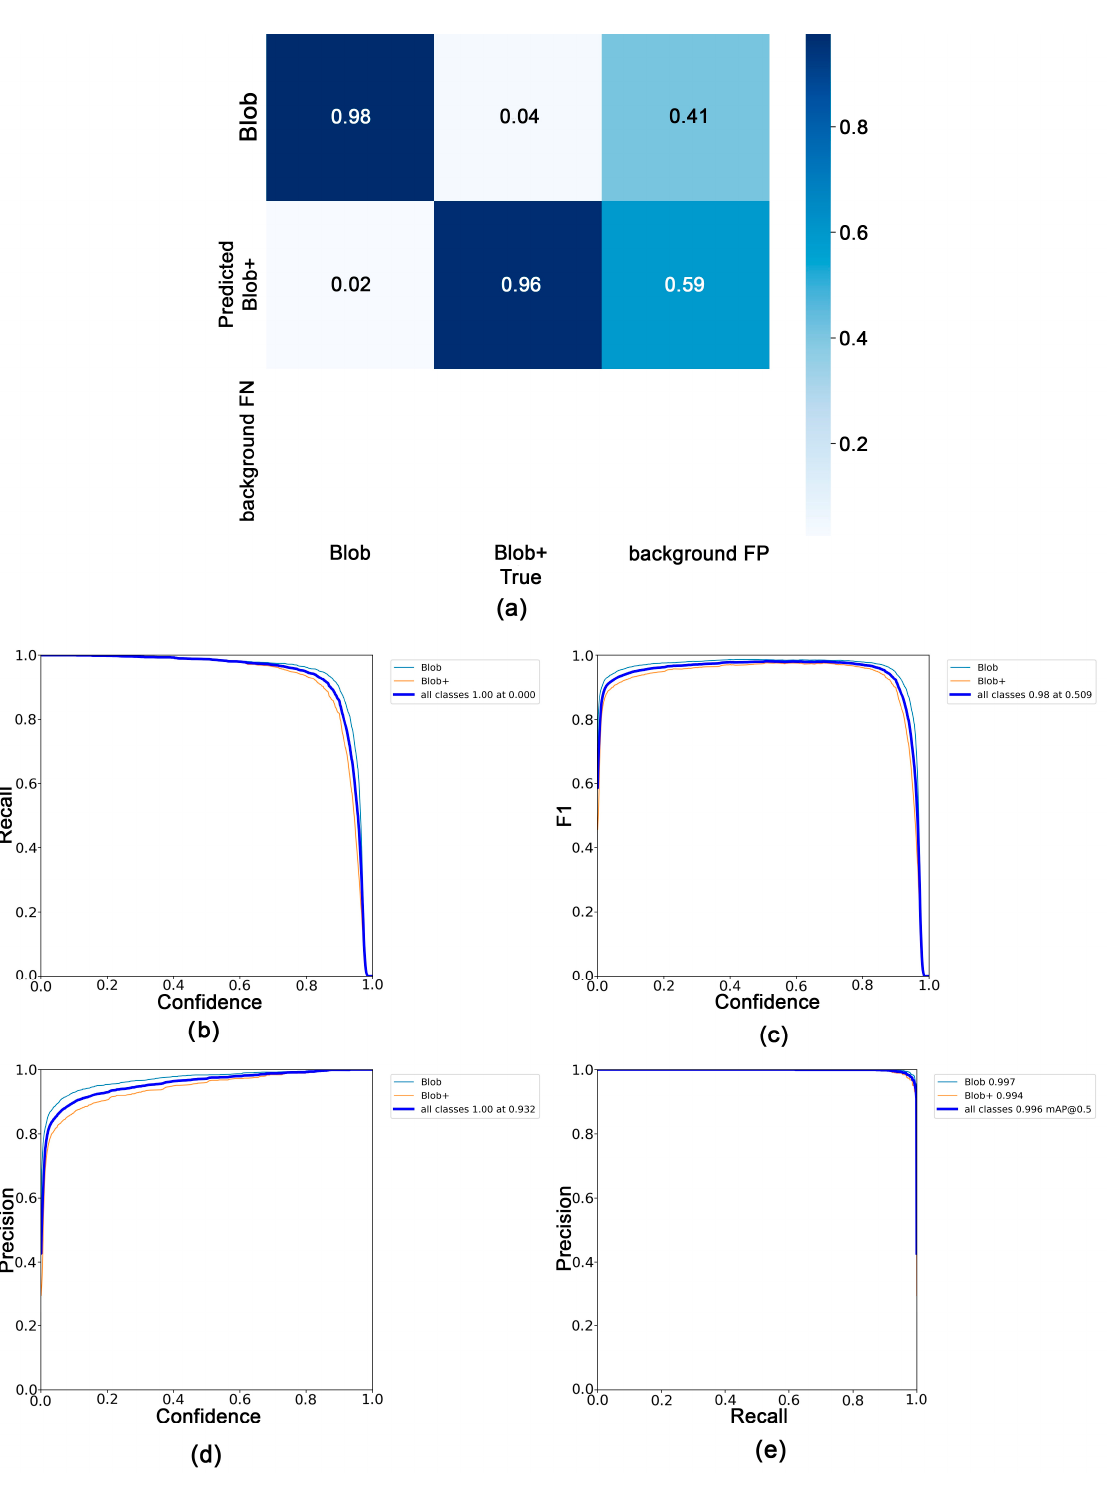
Figure 8. The trained model quality metrics. ( a ) Confusion matrix; ( b ) Dependency Recall- Confidence; ( c ) Dependency F1-Confidence; ( d ) Dependency Precision-Confidence; ( e ) Dependency